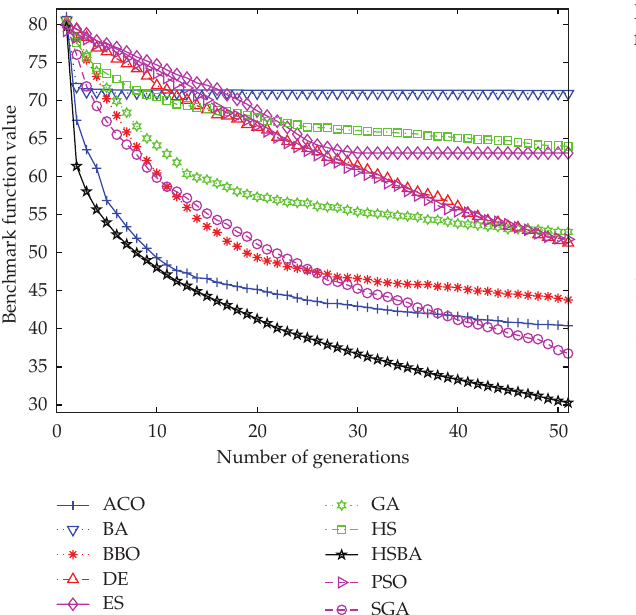
Figure 14: Comparison of the performance of the different methods for the F14 Step